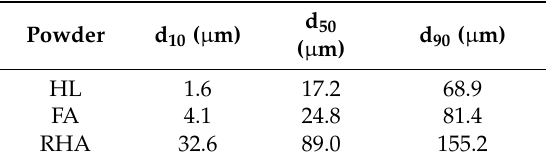
Table 6. Particle sizes at 10% (d 10 ), 50% (d 50 ) and 90% (d 90 ) of the cumulative distribution for HL, FA and RHA powders.